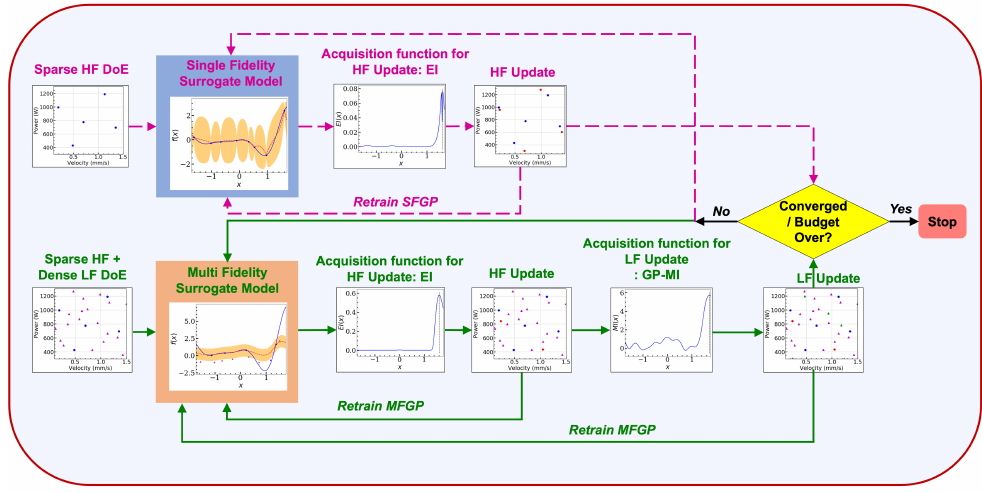
Figure 14. Framework of the MFGP and the SFGP Bayesian Optimization routines. The solid green line indicates the path of MFGP-BO and the dashed magenta line indicates the path of